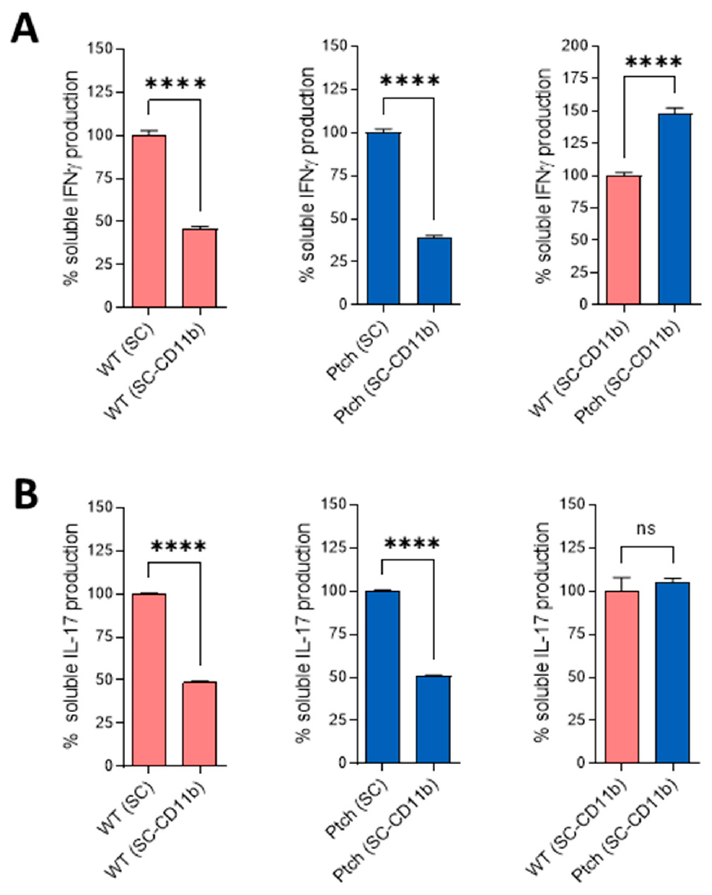
Figure 5. Effect of CD11b + fraction depletion in complete spleen-cell populations. Spleen cells from wt and ptch +/ − mice were depleted of the CD11b fraction and stimulated by using α CD3/ α CD28 for three days. The IFN γ ( A ) and IL17 ( B ) productions were determined by using ELISA. The different compared populations are specified at the bottom of each histogram. Data are the means of three independent experiments in which each sample was assayed in quadruplicate. Each sample corresponds to a pool of spleen or LN cells from three mice. Statistical significance is indicated as **** p < 0.0001 and ns (not significant). Standard errors of the means are shown.